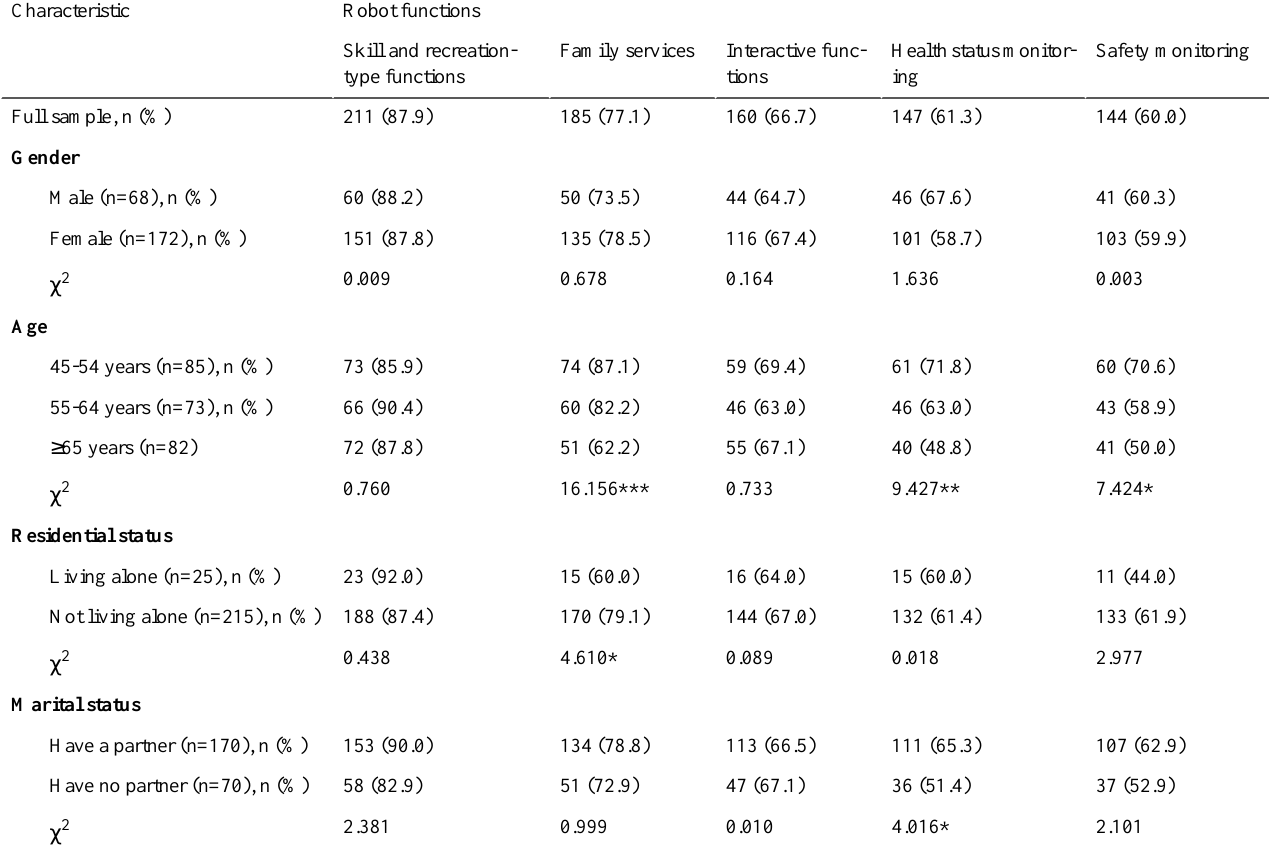
Table 3. Analysis of the preference of middle-aged and older adults for the companionship robot functions (N=240). Robot